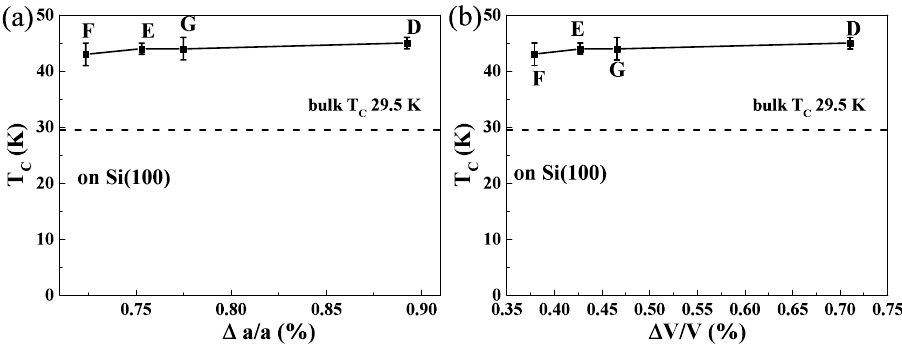
Figure 4. ( a ) Curie temperature as a function of the change of lattice constant ‘ a ’ for MnSi films on Si(100) substrates. ( b ) The Curie temperature vs. the change of the cell volume of the same set of MnSi films. The Curie temperature basically stays around 43 K regardless the change of lattice constant or cell volume. The sample ID is indicated in the figures around the corresponding data point.